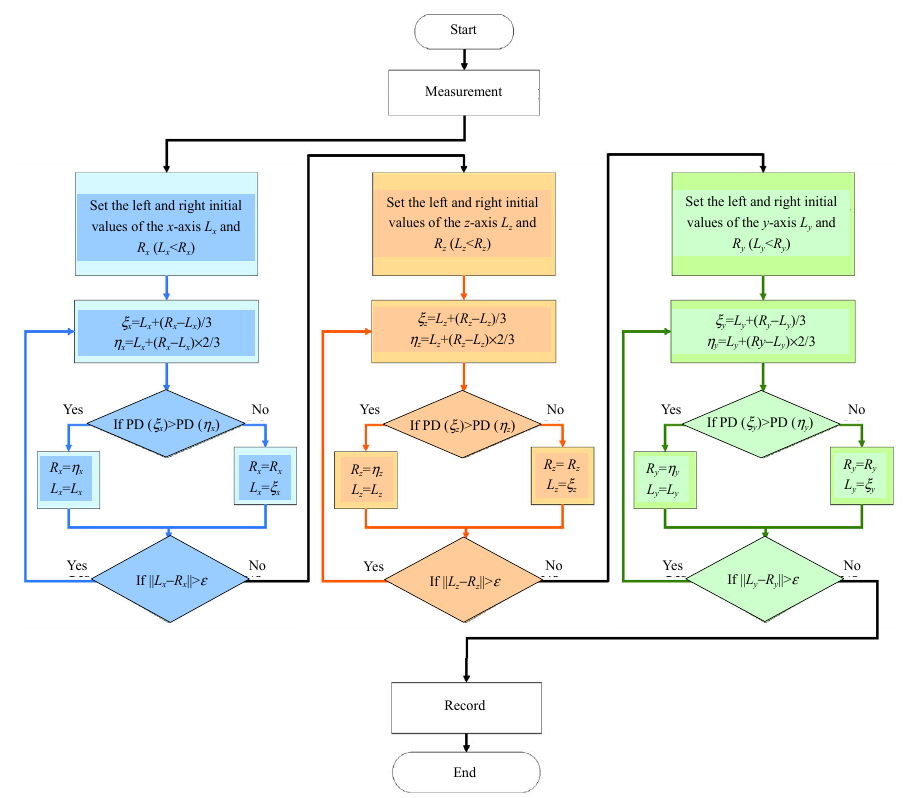
Fig. 4 Flow diagram of the residual magnetic field measurement using the TSA in the SERF